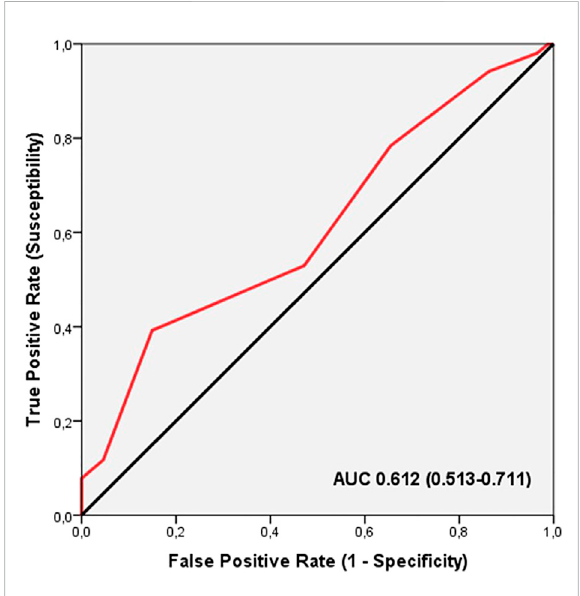
FIGURE 2 Receiver operating characteristic curve (ROC)